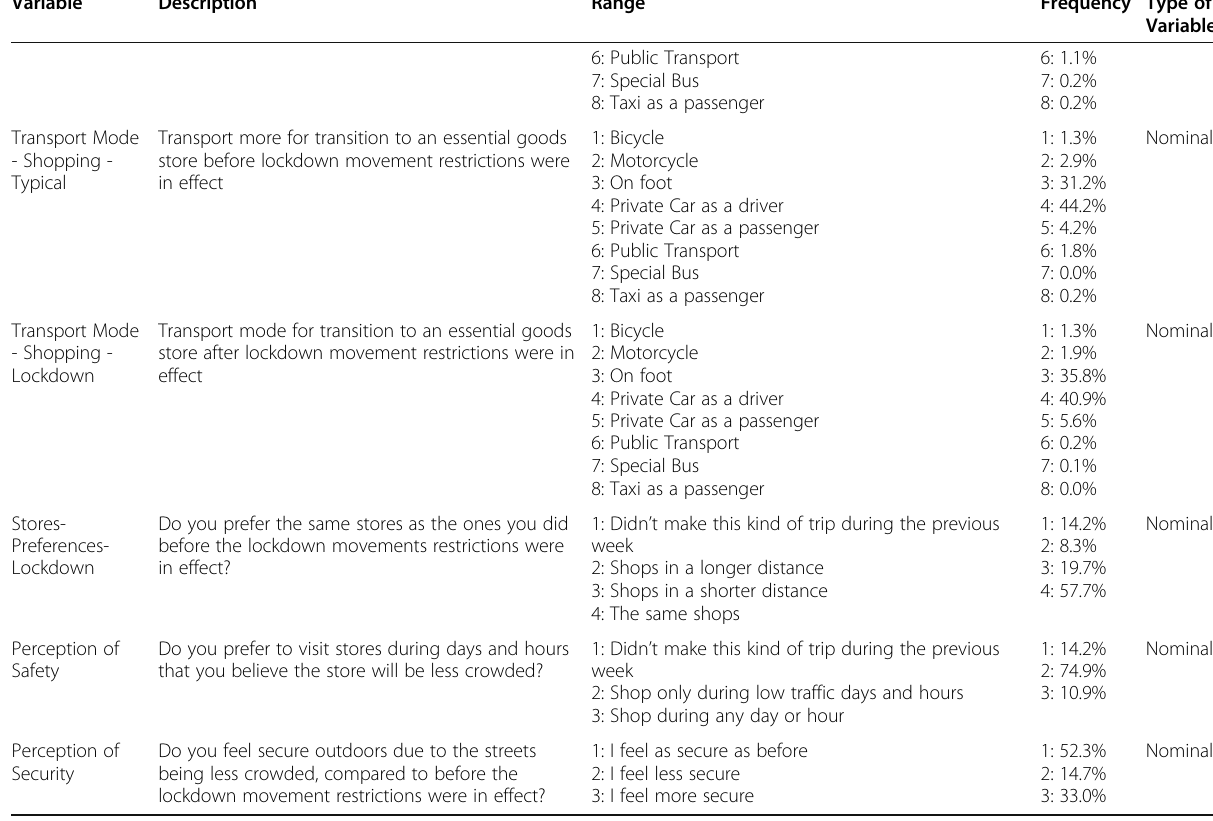
Table 6 Descriptive characteristics of main nominal/ordinal variables (Continued)